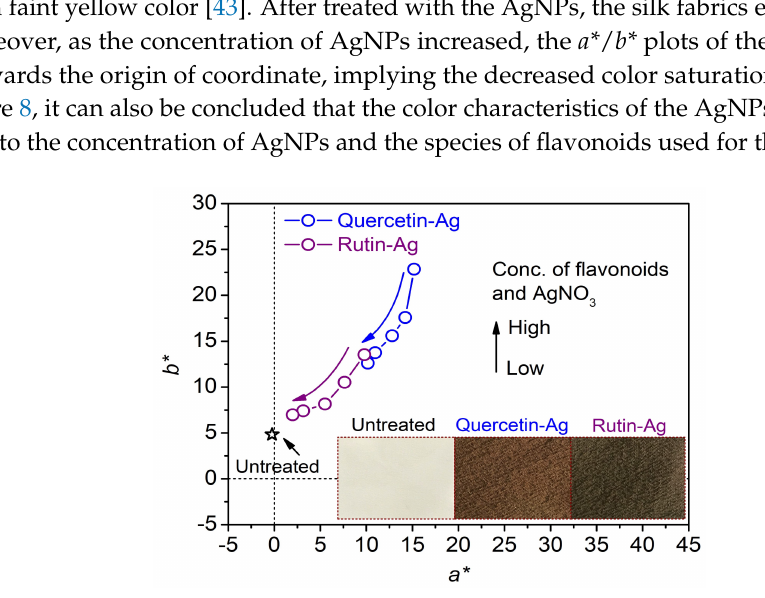
Figure 8. Color parameters of the silk fabrics treated with the AgNPs synthesized with different concentrations of flavonoids and AgNO 3